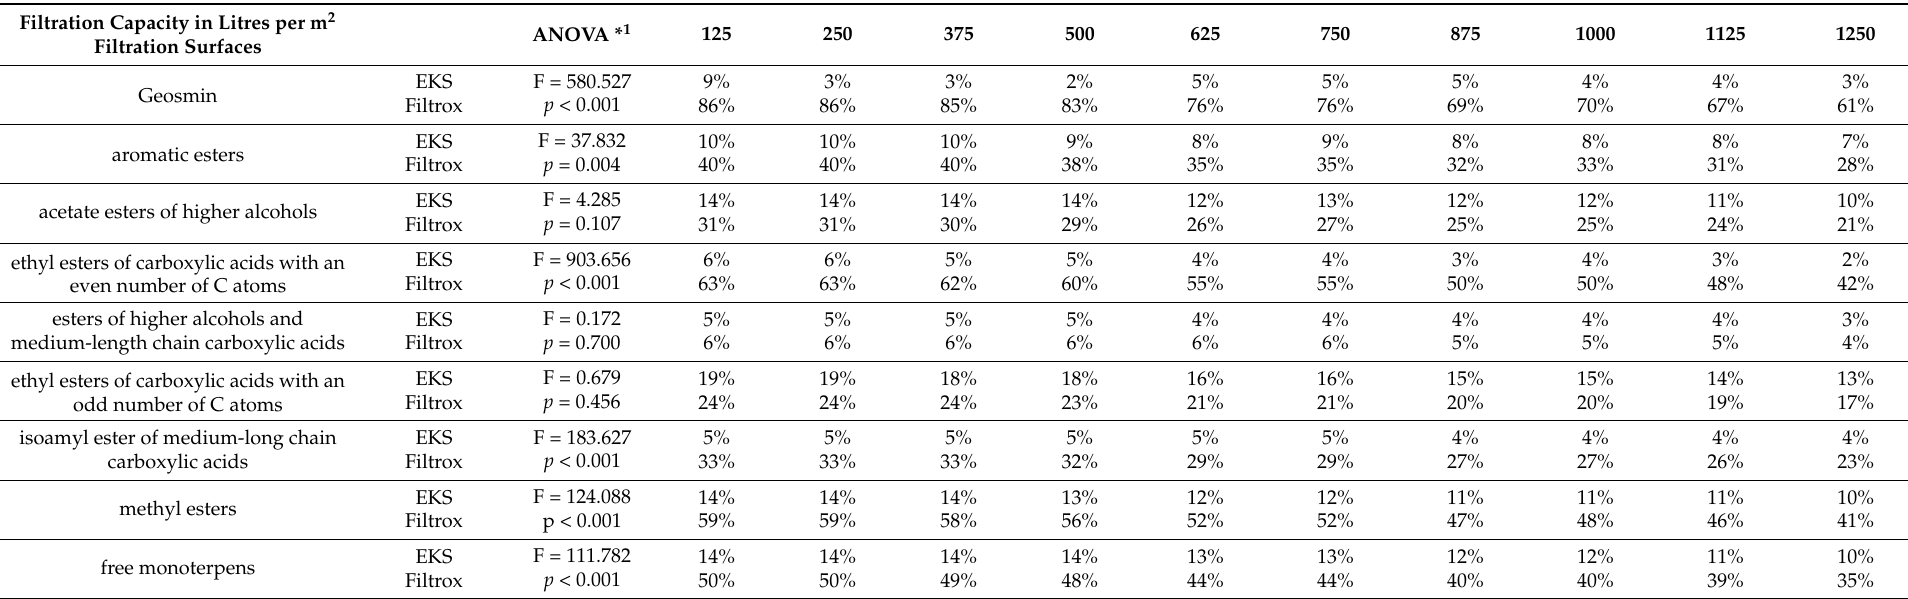
Table 3. Reduction in geosmin and aroma loss of ester compounds and free monoterpenes in the course of a normal EKS filtration and filtration with Fibrafix ®